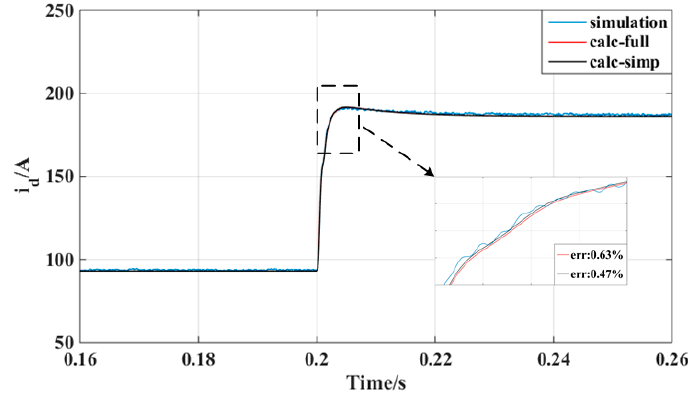
Figure 7. The waveform of the grid current peak value (load step).